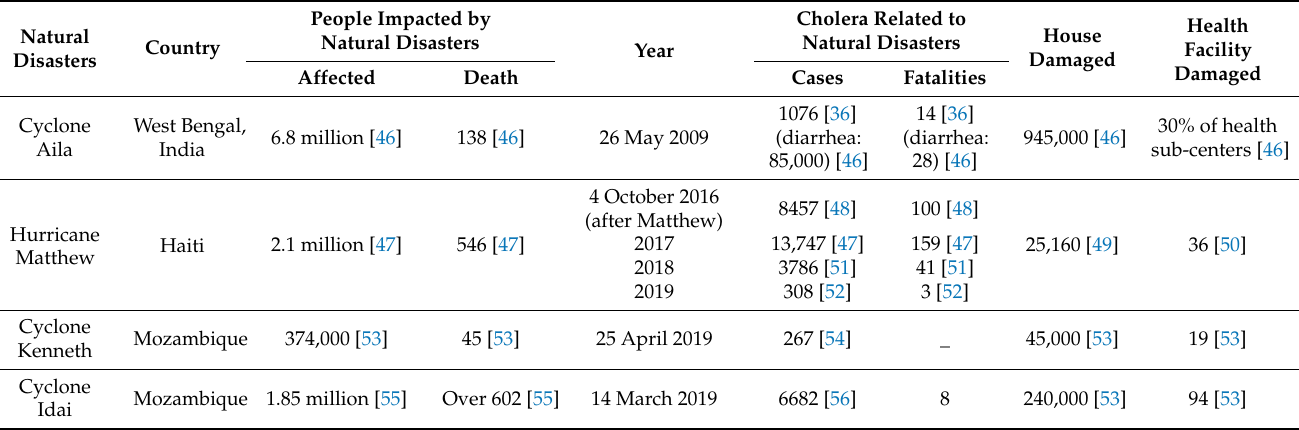
Table 1. Cyclone/hurricane-related cholera outbreaks.